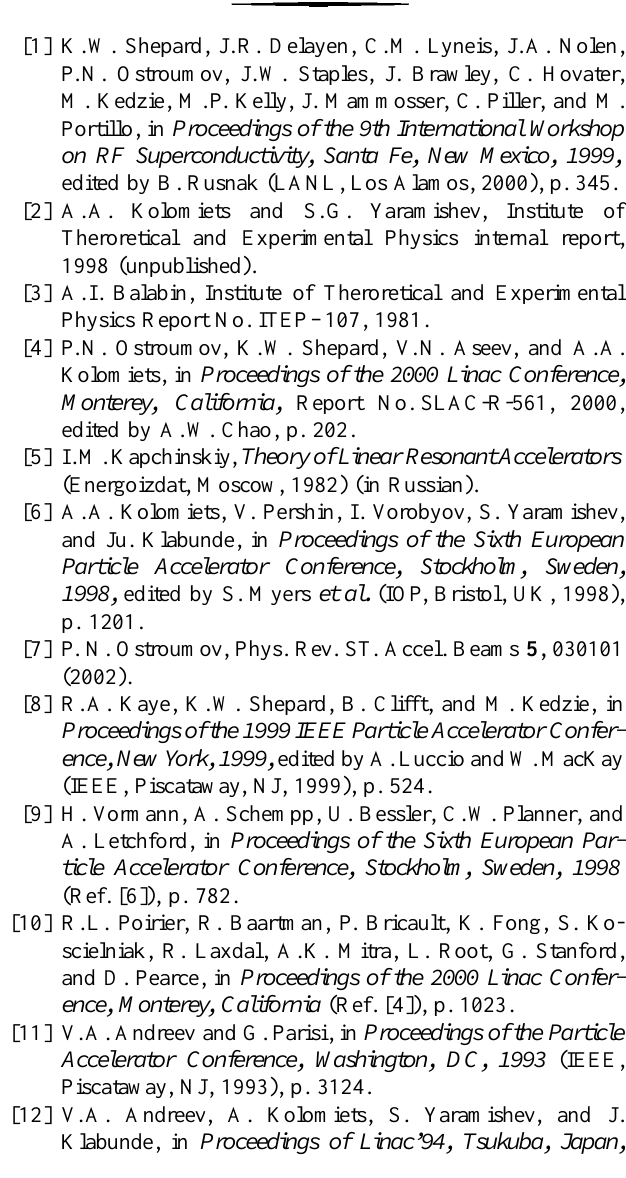
FIG. 14. Transverse electric field along the RFQ with unmodu- lated